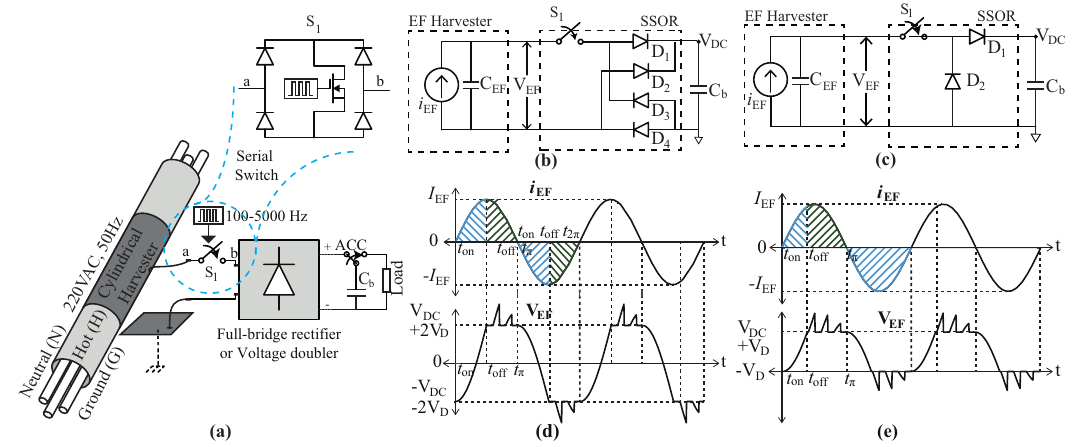
Figure 4. Serial switch-only rectifier (SSOR); ( a ) schematic diagram of experimental setup; ( b ) depiction of the SSOR circuit connected to a full bridge rectifier; ( c ) depiction of the SSOR circuit connected to a voltage-double circuit; ( d ) current and voltage waveforms for a SSOR connected to a full bridge rectifier; ( e ) current and voltage waveforms for a SSOR connected to a voltage doubler